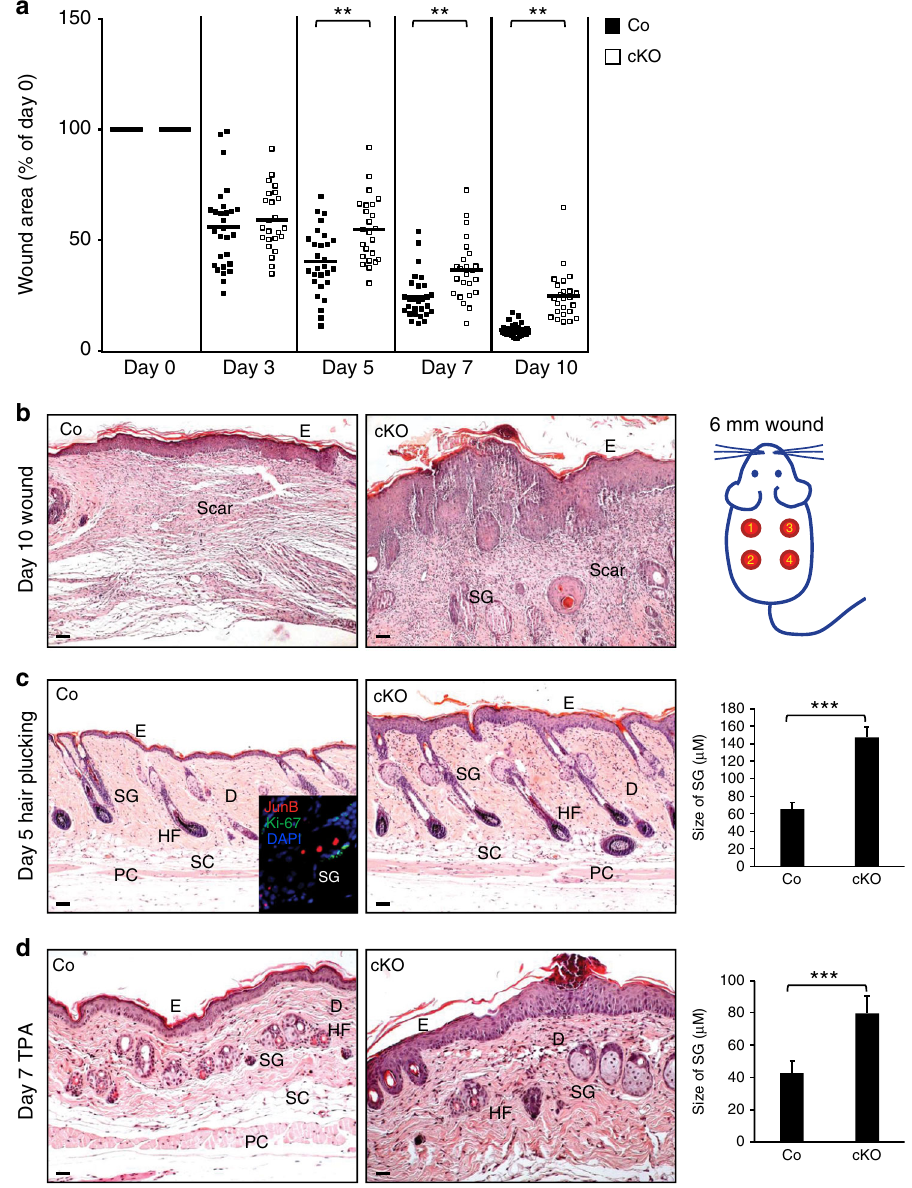
Fig. 3 Impaired wound healing and stress response in JunB cKO mice. a JunB cKO mice display delayed wound healing compared to wild type mice following 6 mm full-thickness circular biopsy punch excision. ** P < 0.001, one-way ANOVA ( n = 7) b Representative H&E photomicrographs of a 10 days wound depicting a hyperplastic and thickened epidermis and enlarged sebaceous glands in JunB cKO mice compared to wild type mice. Scale bars, 50 µ m. c Enhanced epidermal and sebaceous gland hyperplasia in JunB cKOs at day 5 following hair plucking. Inset image depicts opposing role of JunB (red) on proliferating cells marked in green with Ki67. Quanti fi cation of the size of sebaceous glands following hair plucking, *** P < 0.001, t -test ( n = 3). d The topical application of TPA, a strong enhancer of proliferation, for 7 days markedly triggered epidermal and sebaceous gland hyperplasia. Quanti fi cation of the size of sebaceous glands after TPA application, *** P < 0.001, t-test ( n = 3). E, epidermis; D, dermis; HF, hair follicle; SG, sebaceous gland;